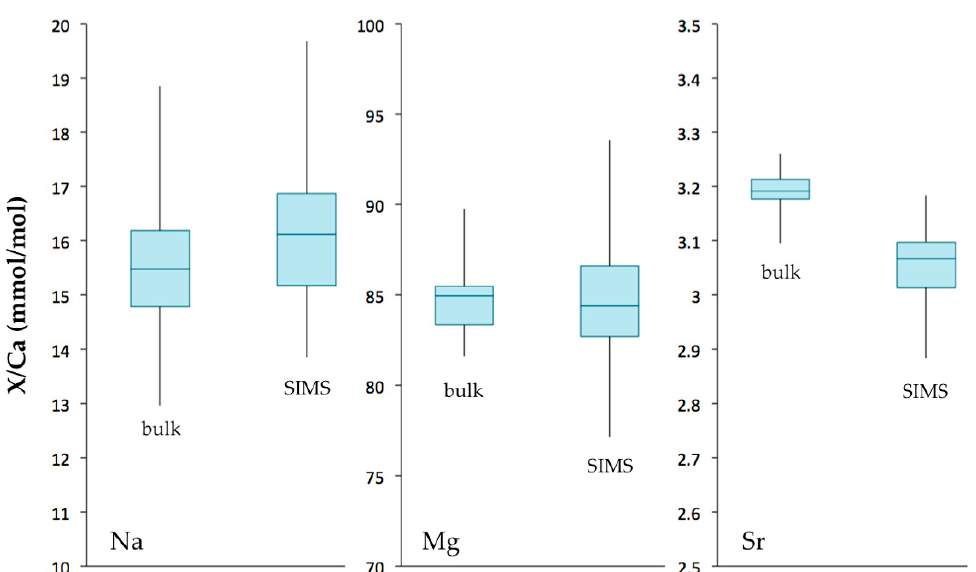
Figure 10. Box plots of Na/Ca, Mg/Ca and Sr/Ca ratios (mmol/mol) measured in Valpareso coral sample by bulk and SIMS techniques. The lower and upper levels of boxes are at the 25th and 75th percentiles, respectively. The center horizontal line is the median value. Whiskers represent the maximum and minimum values.